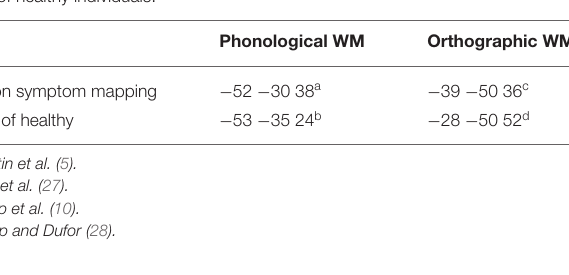
TABLE 1 | Centroids of brain regions associated with phonological and orthographic WM from prior studies using lesion symptom mapping or functional MRI of healthy